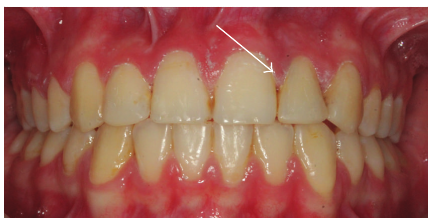
Figure 9: After orthodontic and restorative treatment clinical appearance of fused tooth; intraoral labial view.